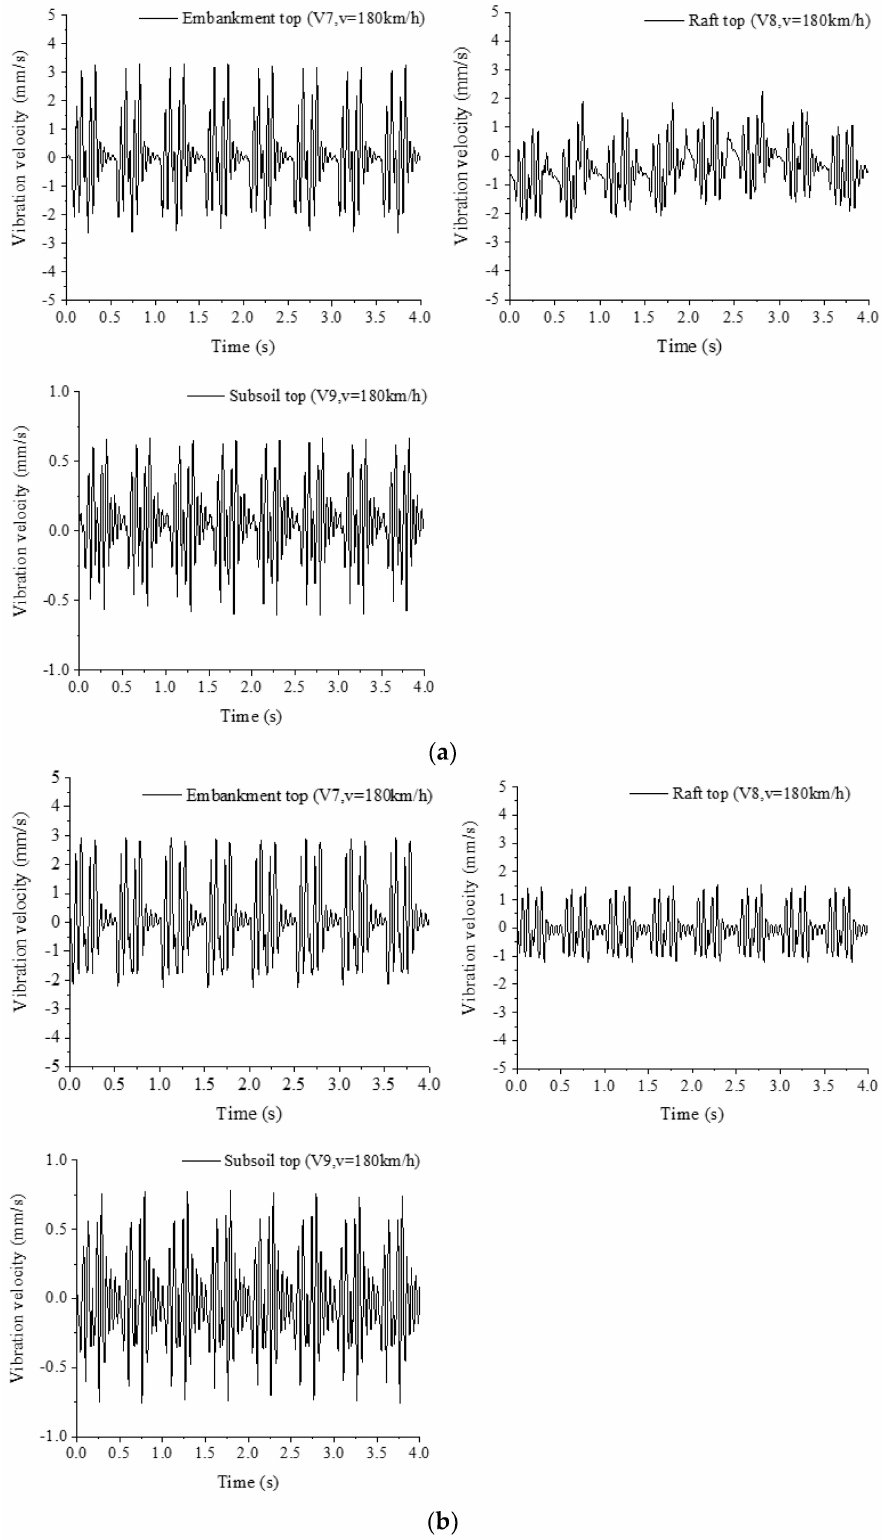
Figure 9. Time histories of vibration velocities at embankment top V7, raft top V8, and subsoil top V9. ( a ) Low water level v = 180 km/h, ( b ) High water level, v = 180